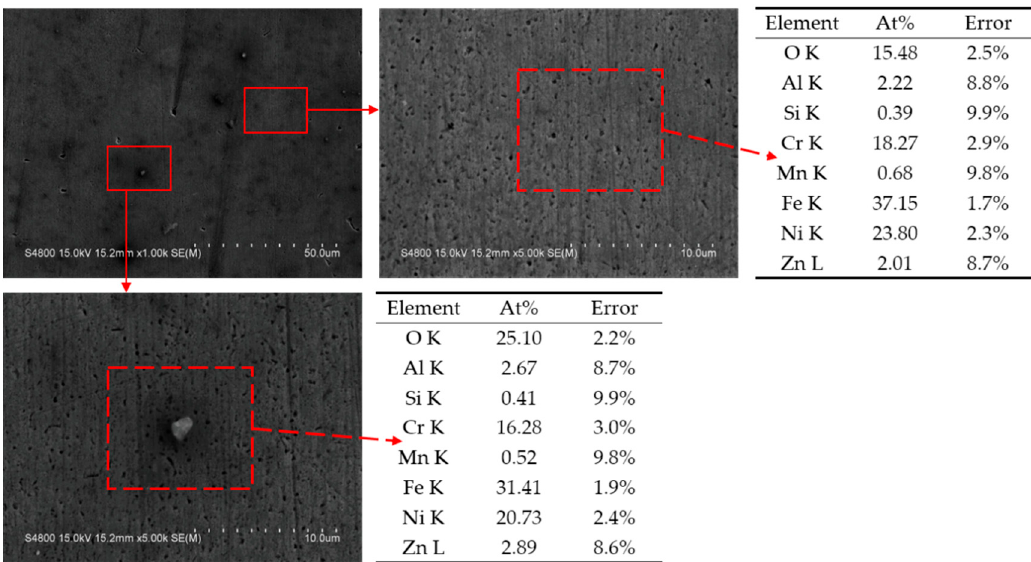
Figure 12. SEM images and the corresponding composition analysis of the passive film formed on In800 with the zinc treatment.